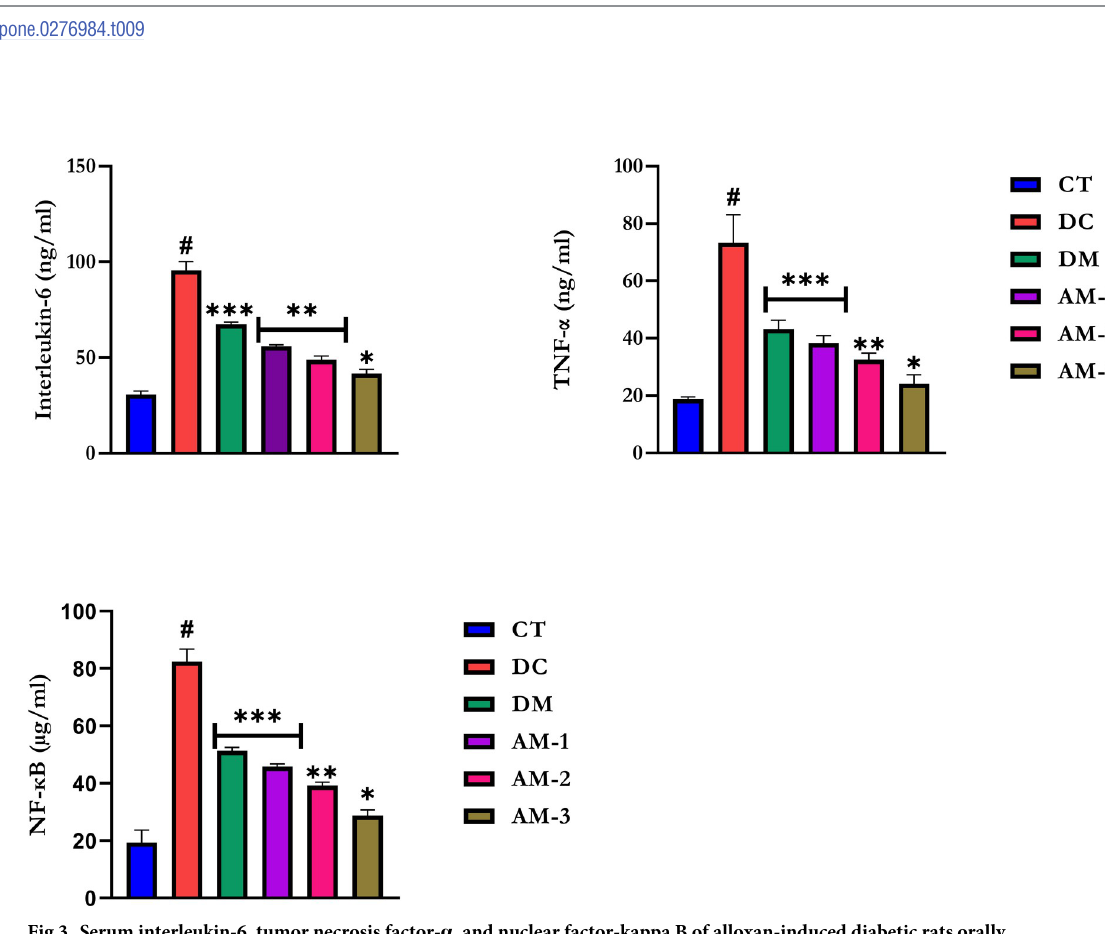
Fig 3. Serum interleukin-6, tumor necrosis factor- α , and nuclear factor-kappa B of alloxan-induced diabetic rats orally administered AEAMP. Data are expressed as mean ± SD (n = 6); AEAMP: aqueous extract of Annona muricata peels; CT: control